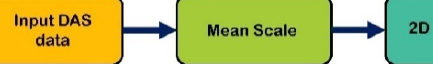
Figure 3. The DAS data processing workflow.